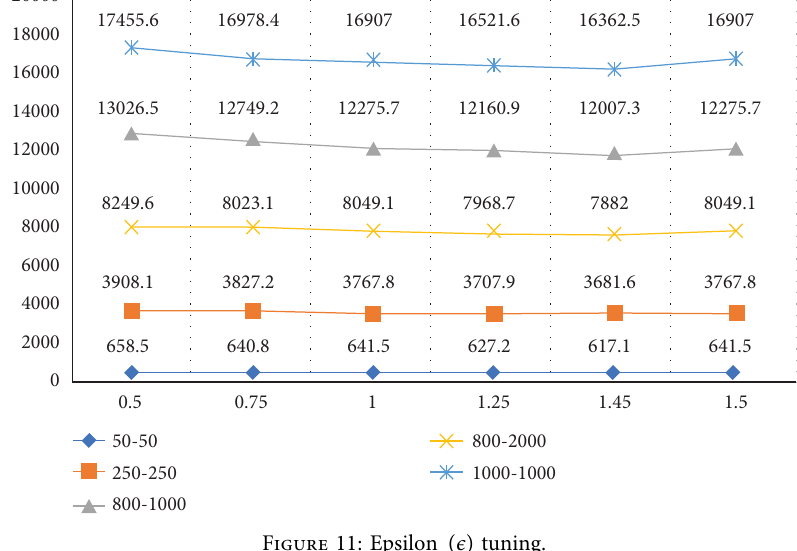
Figure 11: Epsilon ( ϵ ) tuning.